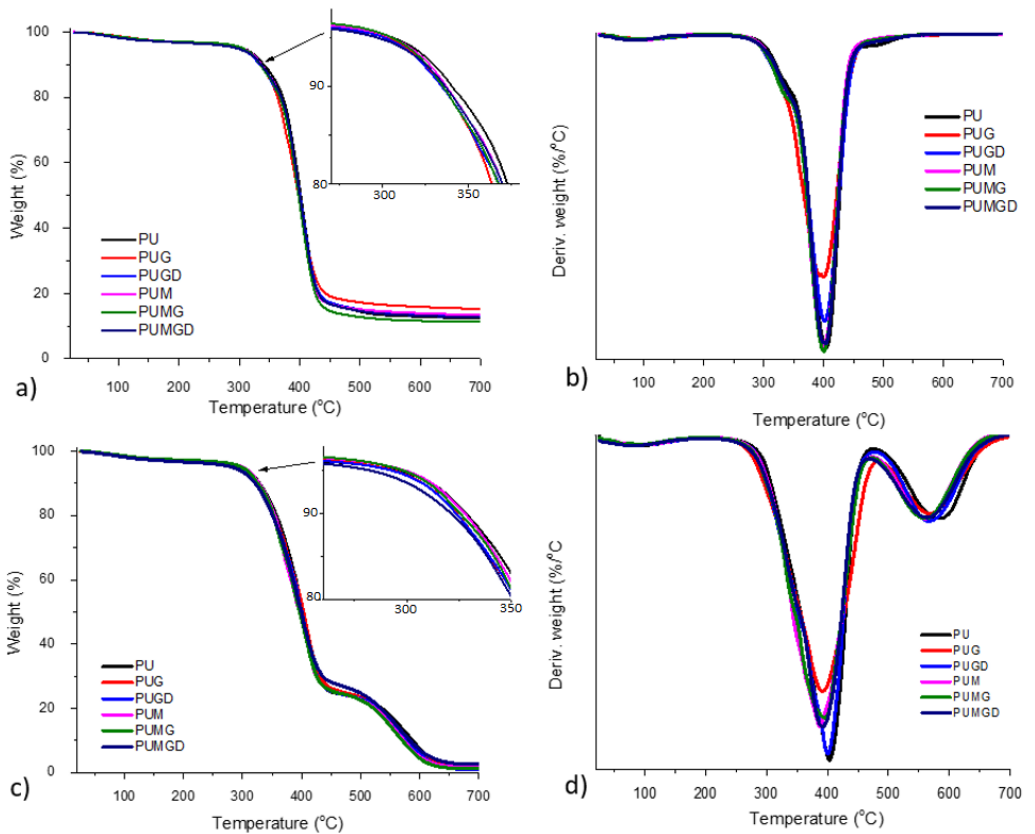
Figure 7. The TG a ) and DTG b ) diagrams of PU and PU nanocomposites under nitrogen atmosphere. The TG c ) and DTG Figure 7. The TG ( a ) and DTG ( b ) diagrams of PU and PU nanocomposites under nitrogen atmosphere. d ) diagrams of PU and PU nanocomposites under air atmosphere. The TG ( c ) and DTG ( d ) diagrams of PU and PU nanocomposites under air Table 5. TGA data for polyurea nanocomposites.